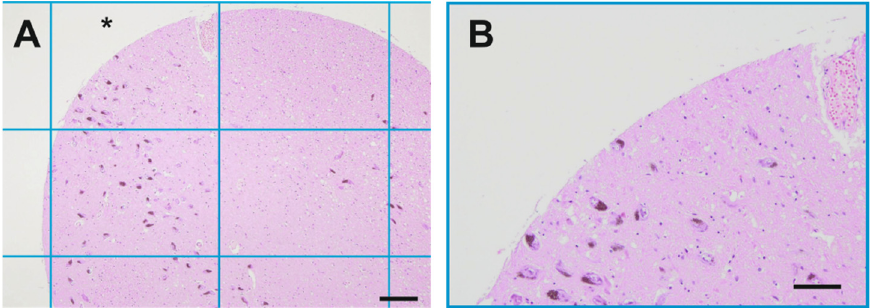
Figure A4. The photomicrograph shows a section of a HE stained MIA ( A ) taken at a magnification of 4× with an overlaid grid representative for the counting method. In each square (star) TH positive, Nogo-A positive cells and neurons expressing both markers were counted (magnification 10×; ( B )). Scale bars: 200 µm ( A ), 100 µm ( B ).